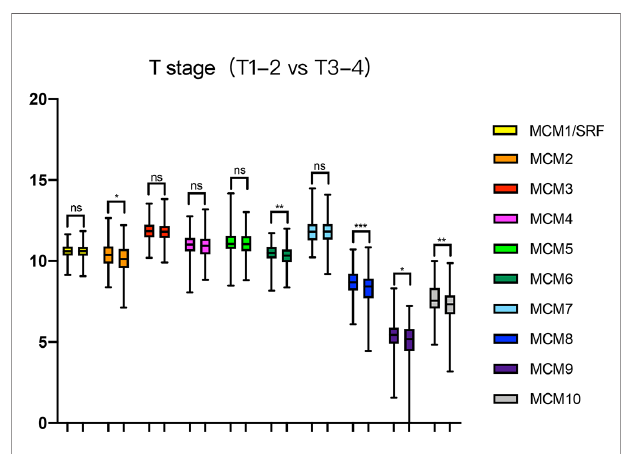
FIGURE 5 | Relationship between transcriptional expressions of distinct MCM family members and T stage of SKCM patients. MCM2/6/8/9/10 showed signi fi cant correlations with T stages in SKCM patients (ns, no signi fi cance; * p < 0.05, ** p < 0.01, *** p <